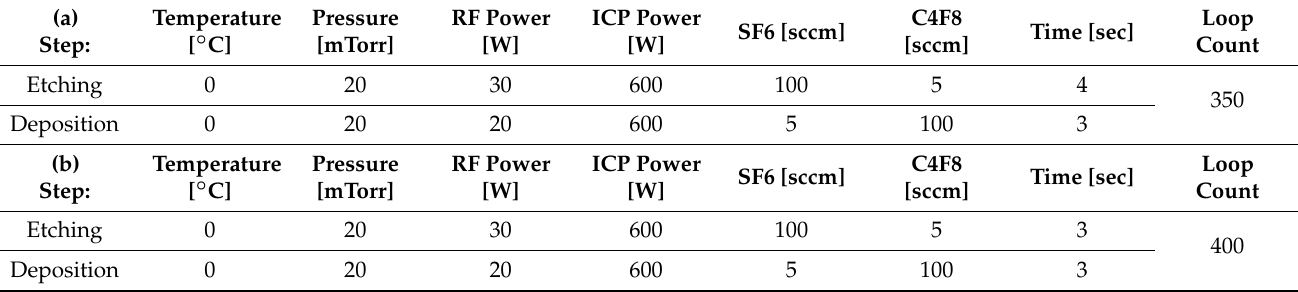
Figure 2. Example of sidewall shape tuning in Si grating with a pitch of 3 µm. Changing the ratio between the times of etching and deposition steps (as shown in Table 1a,b) results in: ( a ) etching with a negative sidewall angle; ( b ) etching with a slight positive sidewall angle, which is suitable for conformal electroplating.